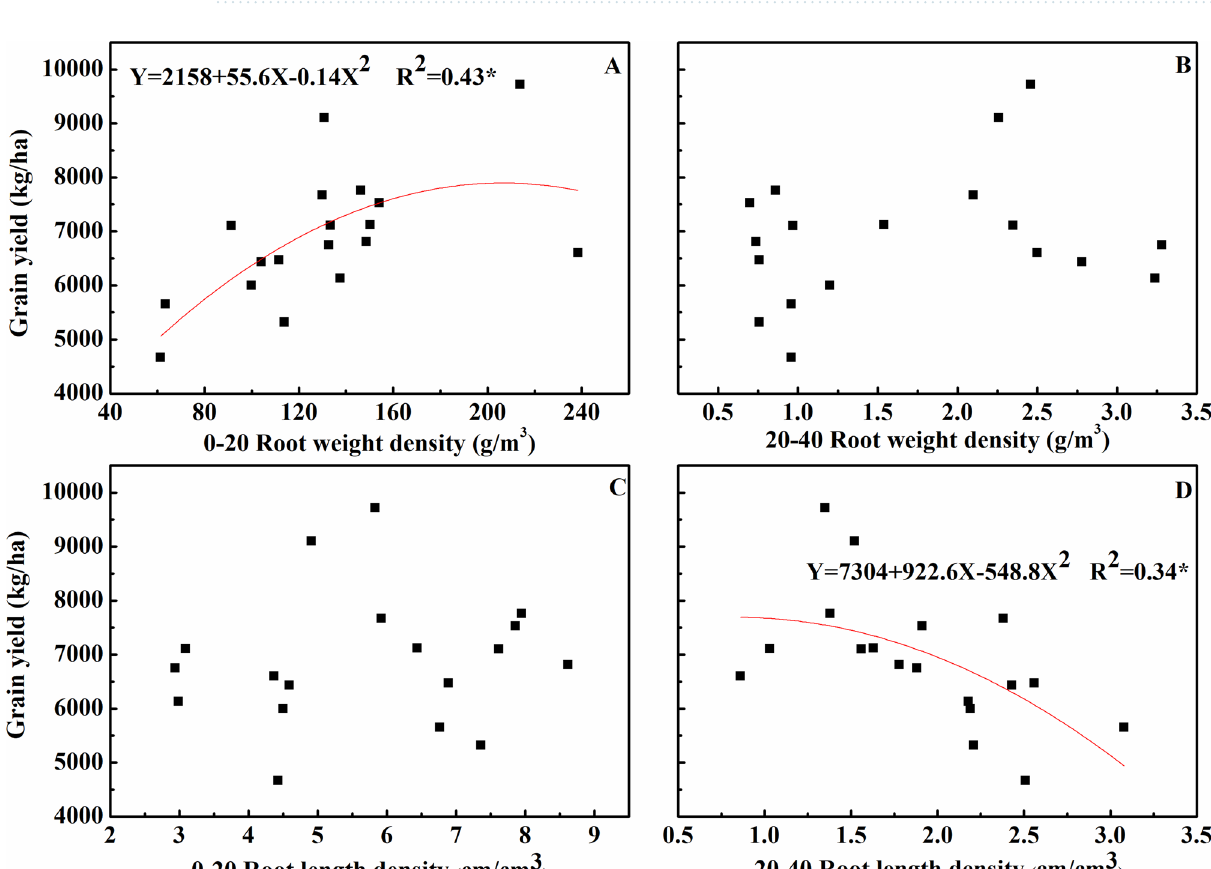
Figure 8. Relationship between the grain yield of Xinchun 6 and root characteristic. ( A ) Relationship between root weight density in 0–20 cm depth and grain yield. ( B ) Relationship between root weight density in 20–40 cm depth and grain yield. ( C ) Relationship between root length density in 0–20 cm depth and grain yield. ( D ) Relationship between root weight density in 20–40 cm depth and grain